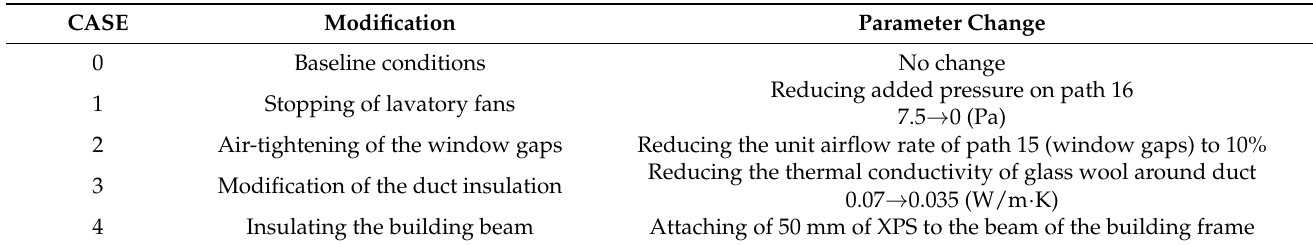
Table 6. Conditions of each